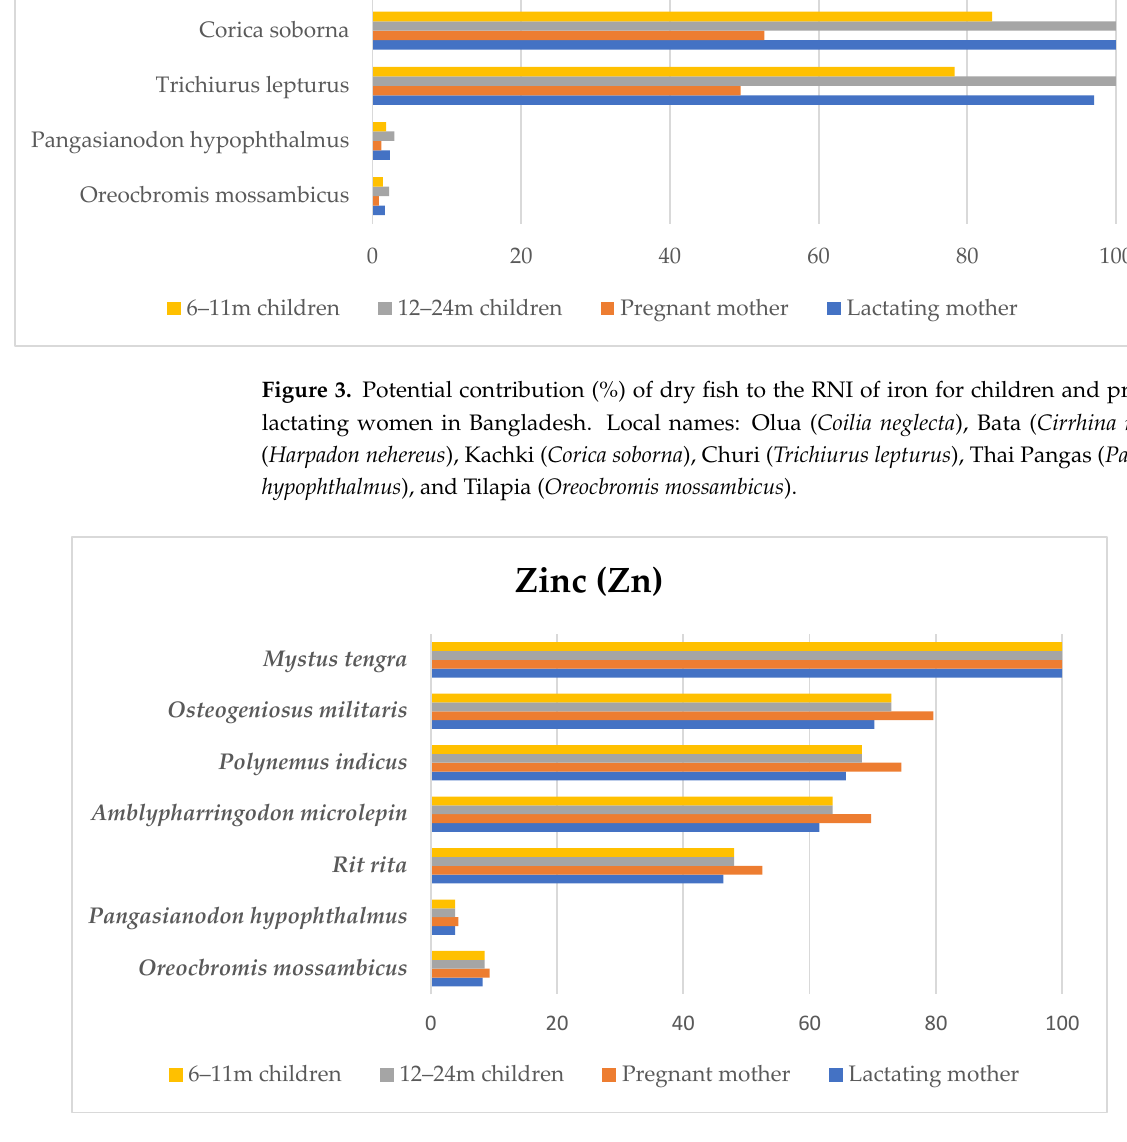
Figure 4. Potential contribution (%) of dry fish to the RNI of zinc for children and pregnant and lactating women in Bangladesh. Local names: Tengra ( Mystus tengra ), Kata mach ( Osteogeniosus militaris ), Lakhua ( Polynemus indicus ), Kachki ( Amblypharringodon microlepin ), Rita ( Rit rita ), Thai Pangas ( Pangasianodon hypophthalmus ), and Tilapia ( Oreocbromis mossambicus ). In 3.90% ( n = 44) of the entries, calcium (Ca) content was reported. According to the data analysis, the calcium content of dry fish varied from 3590 mg (dry Chela) to 33.70 mg (dry Rita) per 100 g of dry fish with an average of 954.61 mg. (Table 1). Figure 5 represents how one serving of dry fish could cover the recommended calcium intake of the target population. The calculation shows that one serving of dry fish could significantly meet the calcium requirement for women and children. We found one serving of the respective dry fishes (i.e., Chela, Olua, Bata, Punti, and Khailsa) could meet 100% of the daily dietary calcium requirement of the women and children. Similarly, dry fish are ahead in the case of potential contribution to the recommended intake of calcium compared to the referenced raw fish (Figure 5). Figure 5. Potential contribution (%) of dry fish to the RNI of calcium for lactating and pregnant women and children in Bangladesh. Local names: Chela ( Salmostoma acinaces ), Olua ( Coilia neglecta ),